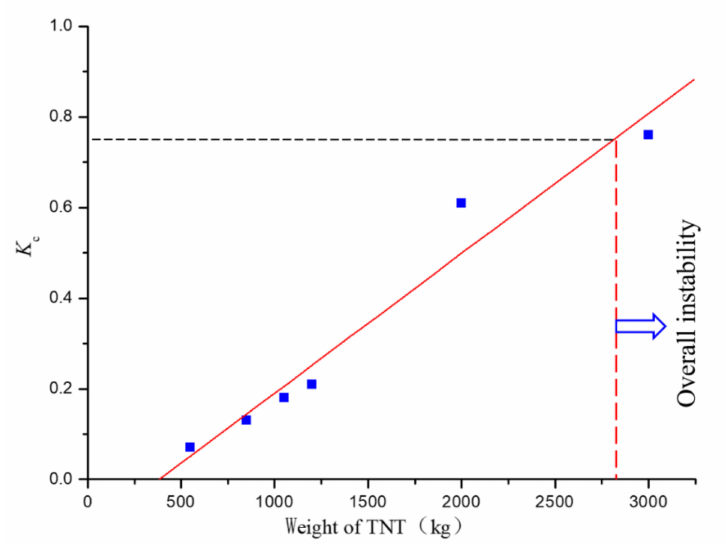
Figure 16. The degree of damage K c to the middle part of the arch dam for different masses of explosive.